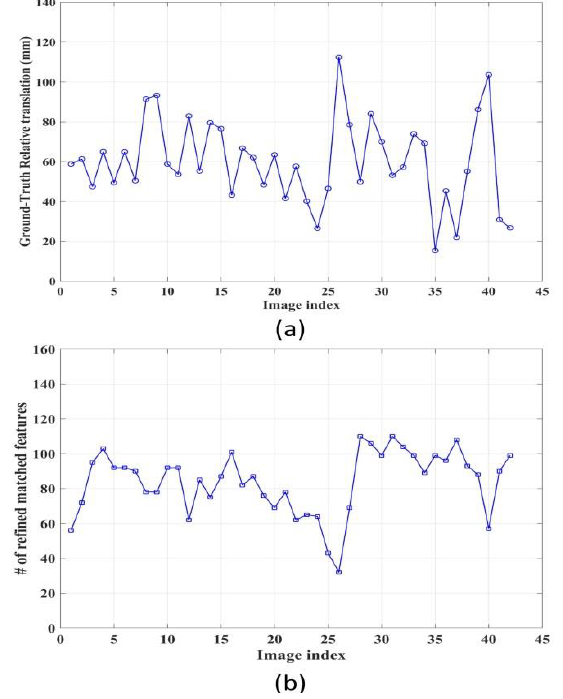
Figure 11. (a) Ground-Truth relative translation (b) Number of refined matched features between successive frames. Table 1. Tranlation and rotation